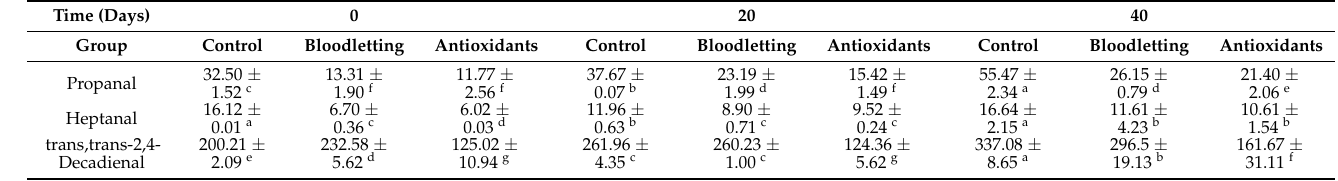
Table 3. The contents of aldehydes in RTE abalone muscle during storage ( µ g/g of